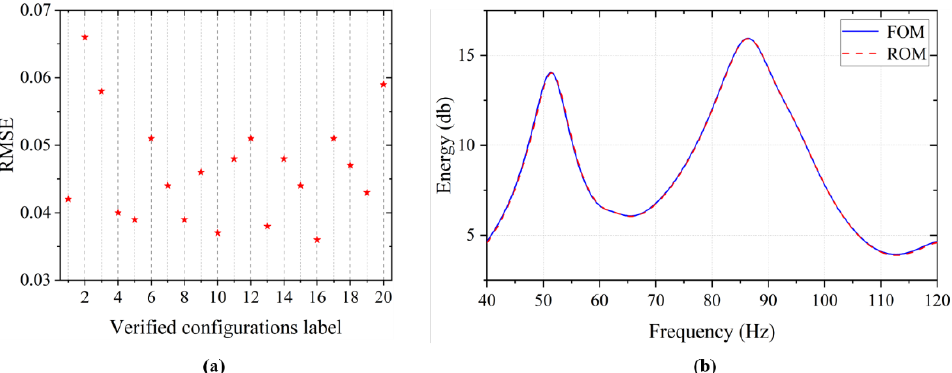
Figure 7. Maximum relative errors of the frequency response energy and the RMSE values of the energy – frequency curves of the FOM and the test ROM.